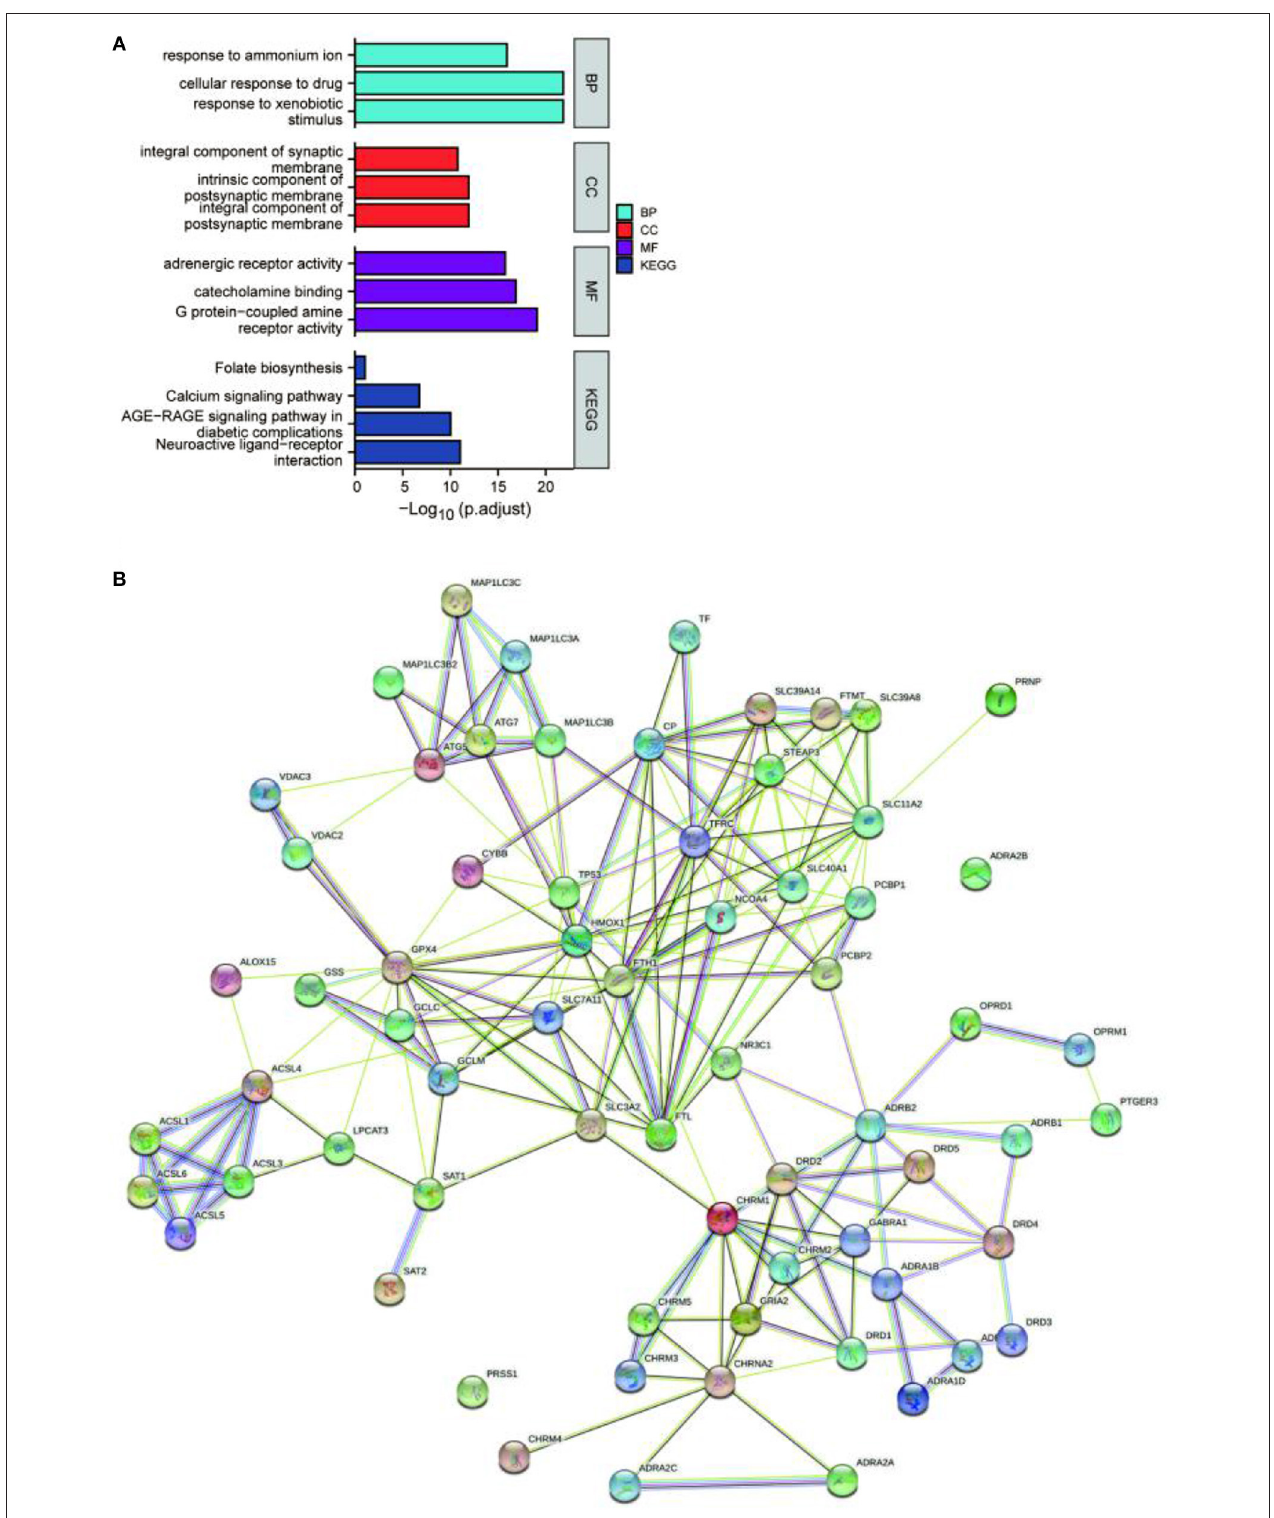
FIGURE 1 | Enrichment analysis and protein-protein interaction (PPI) network of the active compound targets of EUO-TT L. GO functional analysis and KEGG enrichment analysis of the active compound targets of EUO-TT L. drug pair (A) ; PPI network analysis of the target genes of the neuroactive ligand-receptor interaction pathway, and the ferroptosis pathway mediated by the drug pair (B)